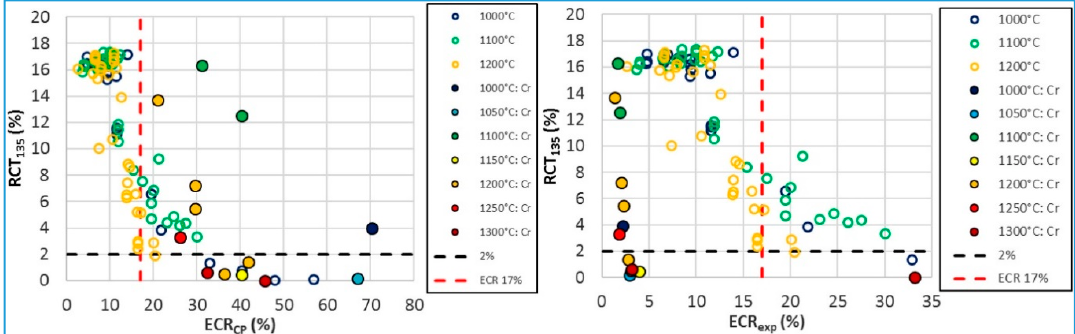
Figure 10. The relation between the post-quenching (PQ) residual ductility of Cr-coated E110 cladding (135 ◦ C, RCT%) and ECR CP and ECR EXP indexes. Reproduced from [18] with copyright permission from